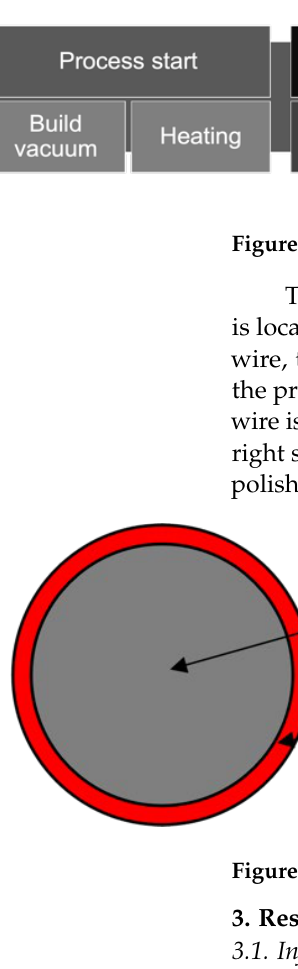
Figure 4. PVD coating on wire surface [16].